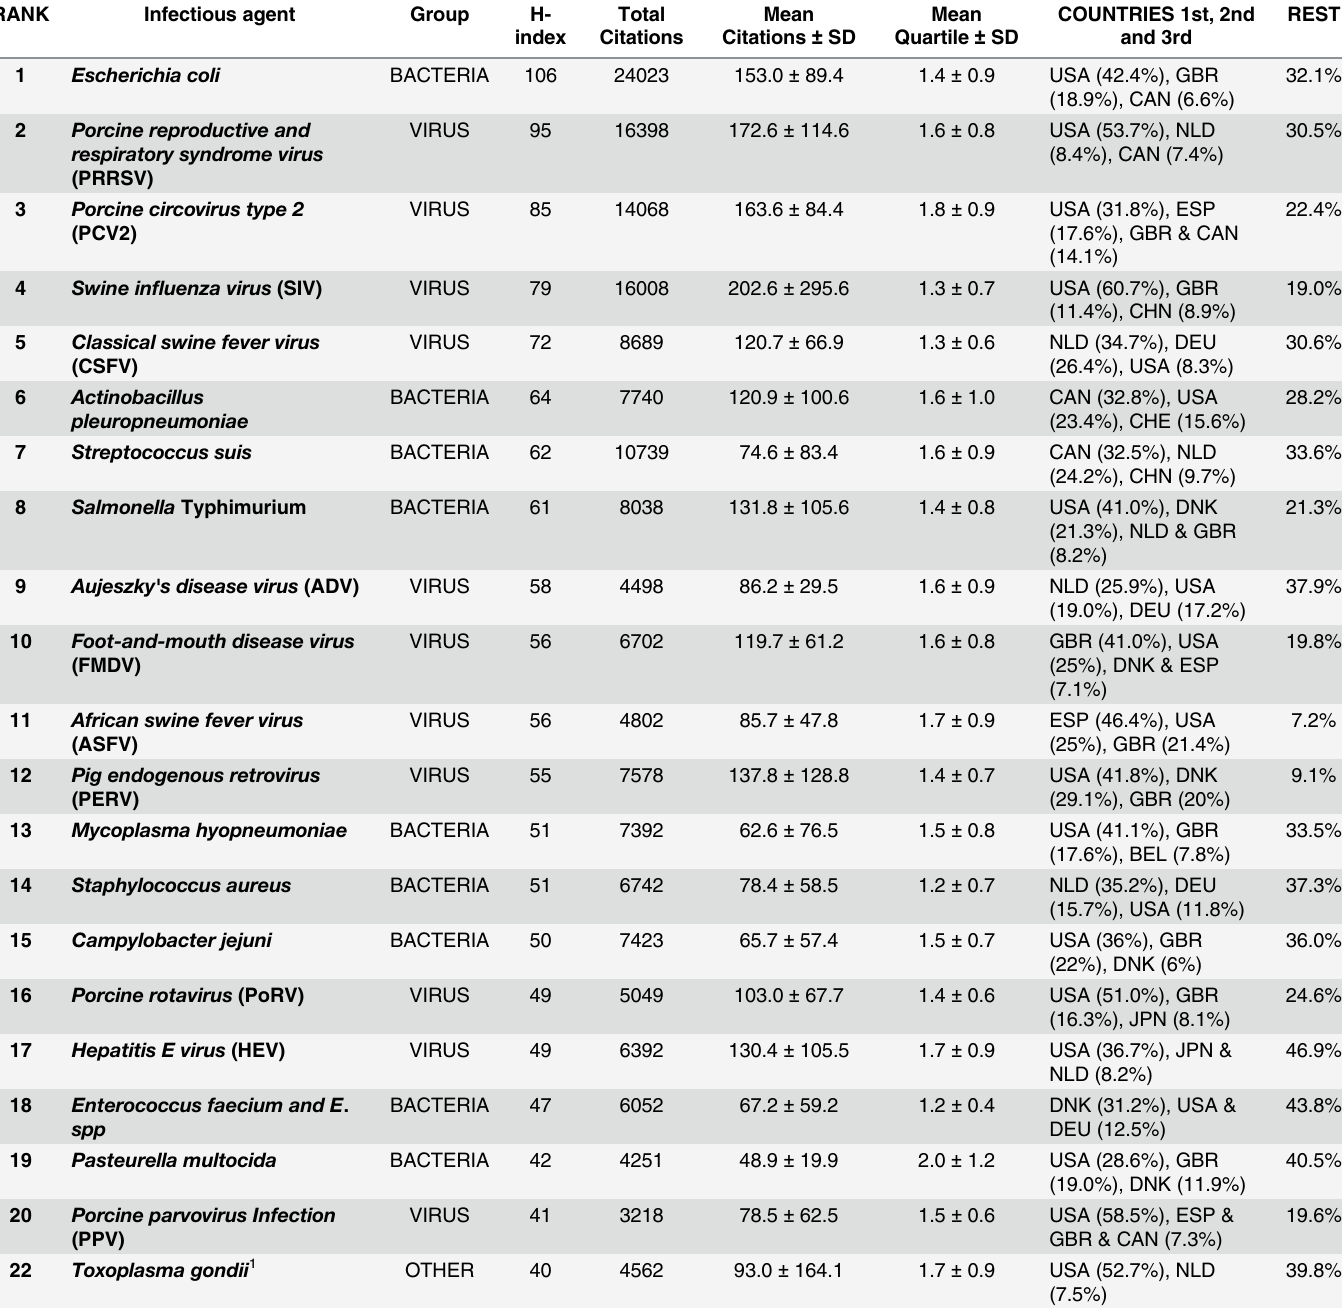
Table 2. Swine infectious agents with the top 20 H-index scores. Rank according to the H-index, infectious agent name, taxonomic group, H-index, total number of citations and mean number of citations of papers ± standard deviation (SD) for the publications included in the H-index core, and mean quartile of the journals ± SD where papers were published as well as origin (country) of the first author affiliation for the papers included in the H-indices for each infec- tious agent (top three countries and